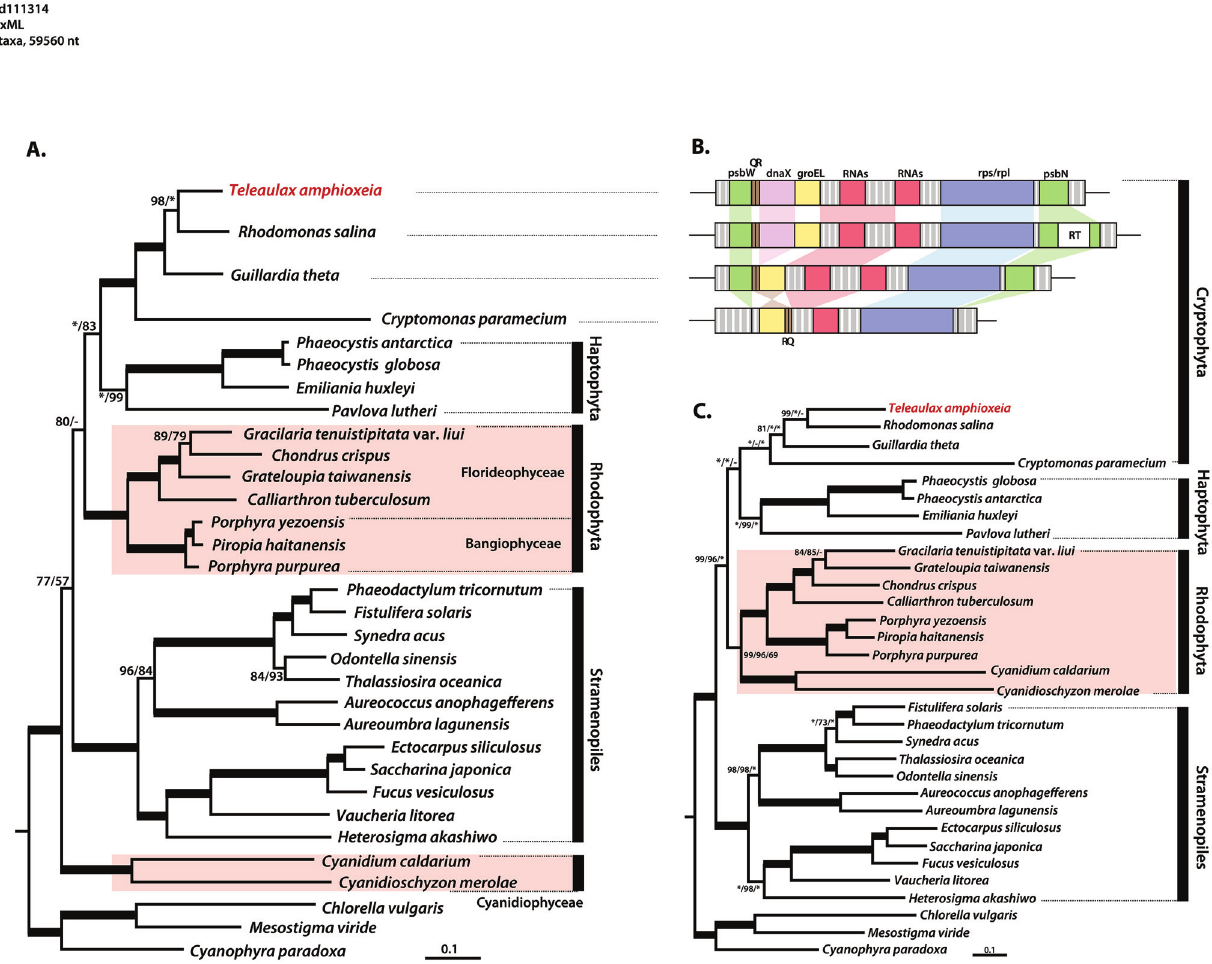
Fig 3. Phylogenetic tree of the cryptophyte plastids. (A) RAxML phylogeny constructed from a concatenate of 93 proteins (18,180 amino acids). The ML and MP bootstrap values are shown above or below the branches. (B) A simple overview of cryptophyte plastid gene synteny. (C) RAxML phylogeny constructed based on 93 protein-coding genes (56,569 nucleotides). The ML, MP and NJ bootstrap values are shown above or below the branches. The bold branches indicate strongly supported values (ML, MP, and NJ = 100%). The asterisks indicate supported values = 100%, and the dashes indicate values with < 50% support. The scale bar depicts the number of